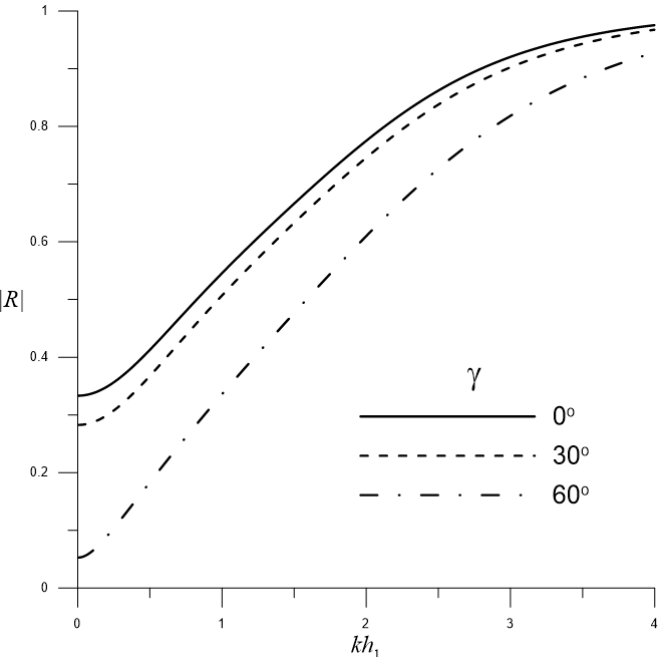
Figure 13. Reflection coefficient | R | varying against kh 1 for a set of one bottom-standing barrier and one surface-piercing barrier by waves with different oblique incidence angles γ .